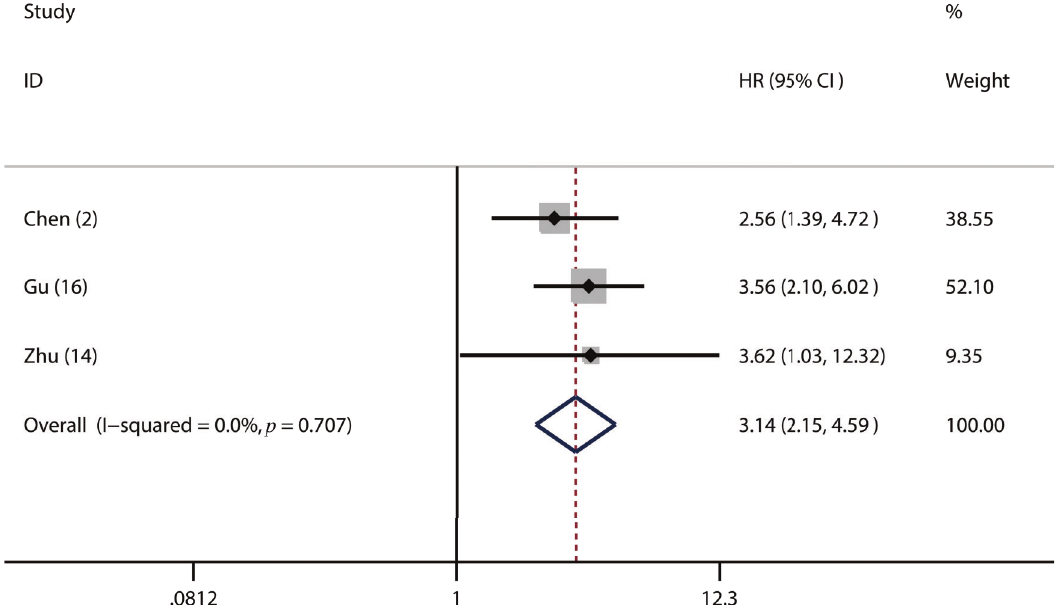
Figure 4 - Forest plot of the hazard ratio (HR) for the association between the plasma fibrinogen level and progression-free survival (PFS) in patients with lung cancer.